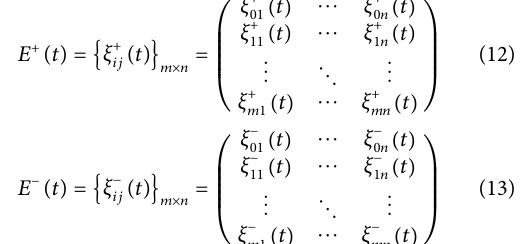
indicators, intermediate indicators and comment (interval) indicators are represented in order. Where, y ij ( t ) represents